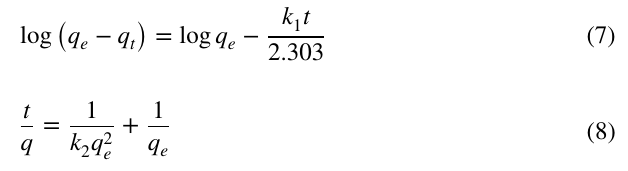
Table 3 Thermodynamics Parameters